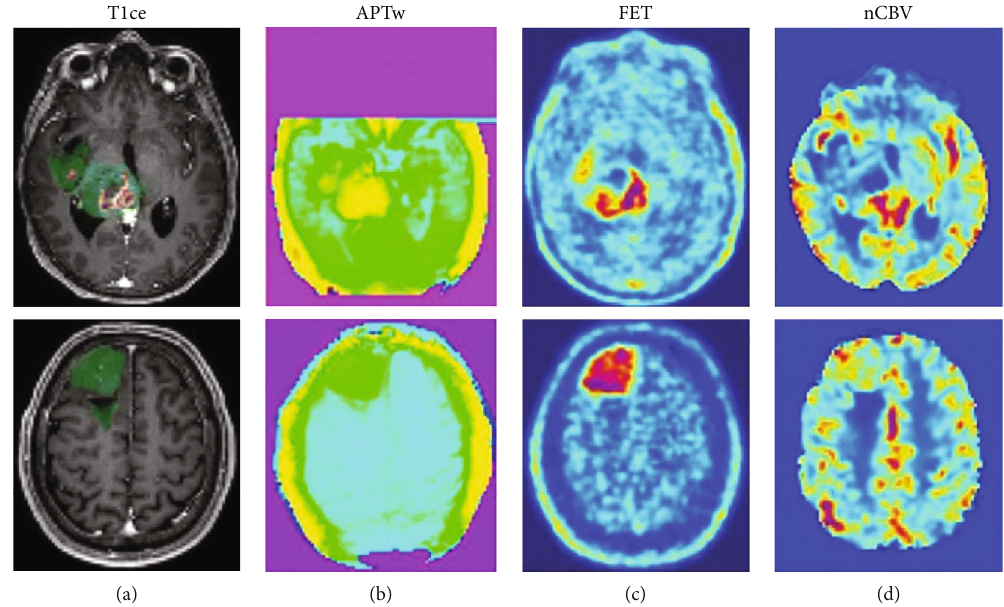
Figure 9: FET PET combined with amide proton transfer (APT) CEST MRI. Example images of a glioblastoma (upper row) and low-grade glioma (lower row). Segmentation (contrast-enhancing tumor (CET) in red, FLAIR hyperintense tumor (FHT) in green) is overlaid on the contrast-enhanced T1-weighted image (a) to show the spatial overlap. FHT in glioblastoma; both amide proton transfer-weighted (APTw) and CBV were signi fi cantly ( P < 0 : 001 , respectively) higher in PET-positive areas. Even in low-grade gliomas, a similar trend was observed for the two imaging modalities ( P = 0 : 085 for APTw and P = 0 : 045 for CBV). Reproduced with permission from Figure 2 of Schon et al.